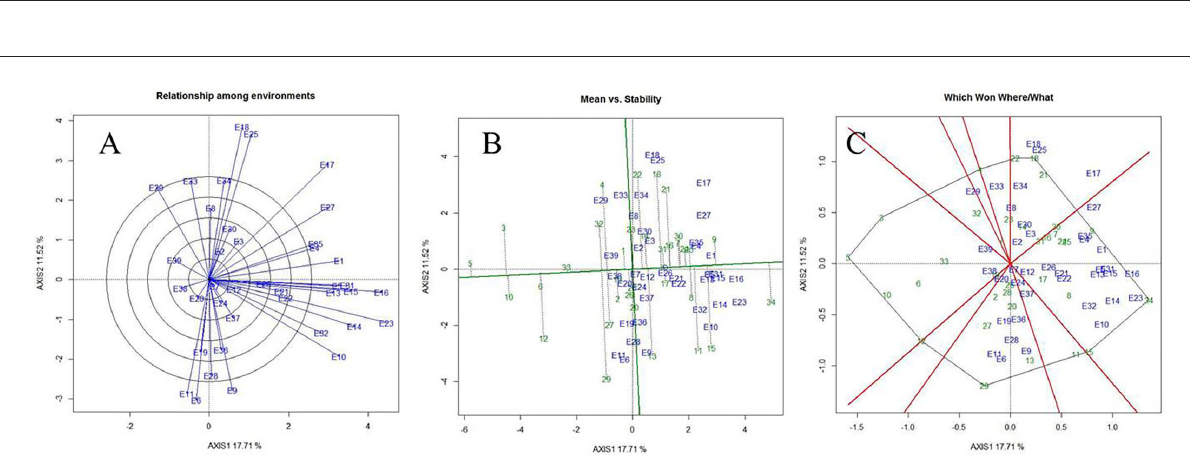
FIGURE7 Relationship among the test environments (A) , mean vs. stability (B) , and ’Which-won-where’ (C) view of test locations based on heritability-adjusted GGE (HA-GGE) biplot analysis of 34 mungbean genotypes across 39 testing locations. No transformation of data (transform 0); and data were centered by means of the environments (centering = i.e., genotype and environment-focused singular-value partitioning. Therefore, it is most appropriate for illustrating the relationship between genotypes and environments. Numbers correspond to environment and genotypes, as listed in Supplementary Tables 1,